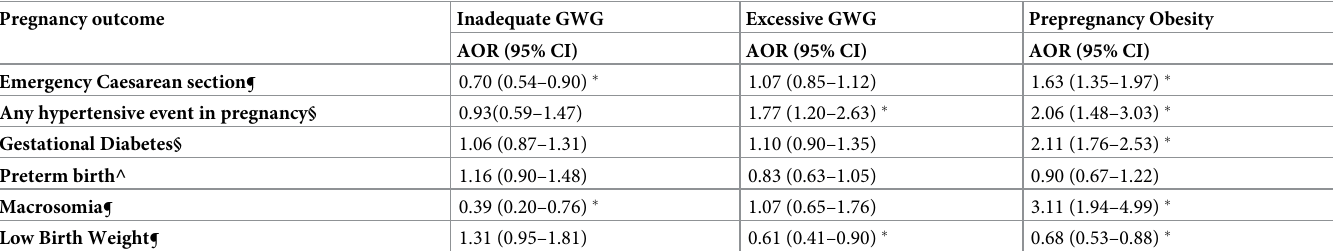
Table 3. Independent effect of gestational wight gain and prepregnancy body mass index on different pregnancy